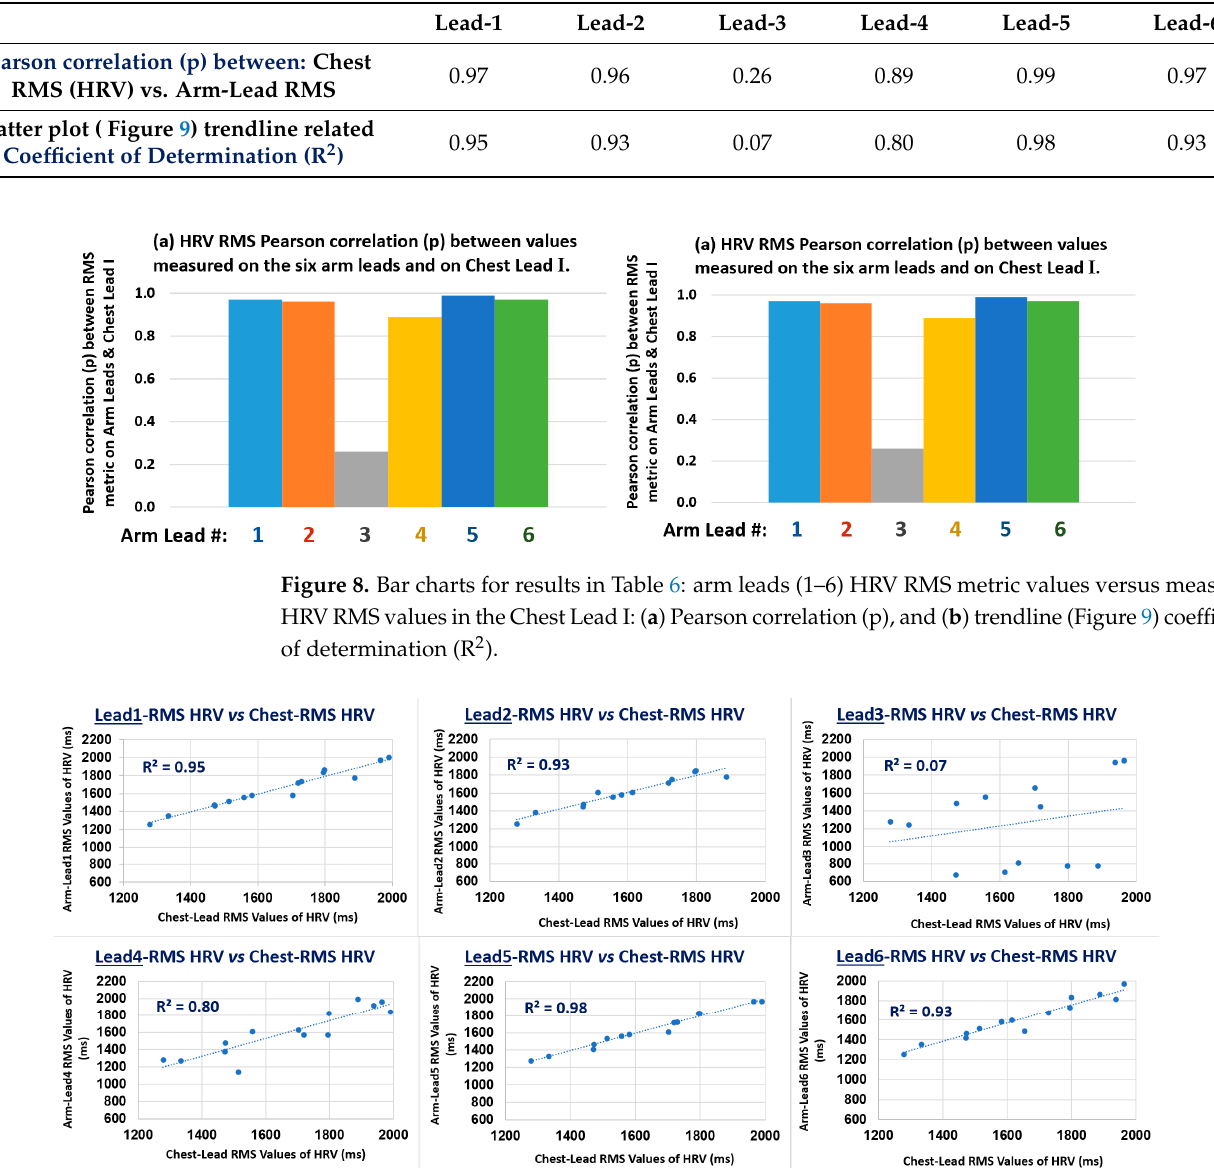
Table 6. Results summary of Pearson correlation coefficient (p) and scatter plot (Figure 9) associated trendline coefficient of determination (R2) between HRV RMS metric (of sinus beats IBI) measured on each of the six bipolar arm leads and on the Chest Lead I ECG (as the gold standard).